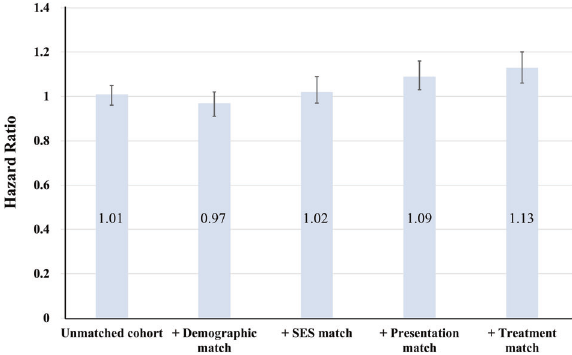
Fig. 3 HRs in four matches. HR of all-cause 5-year mortality risk for sequentially matched non-Hispanic whites vs. non-Hispanic blacks.